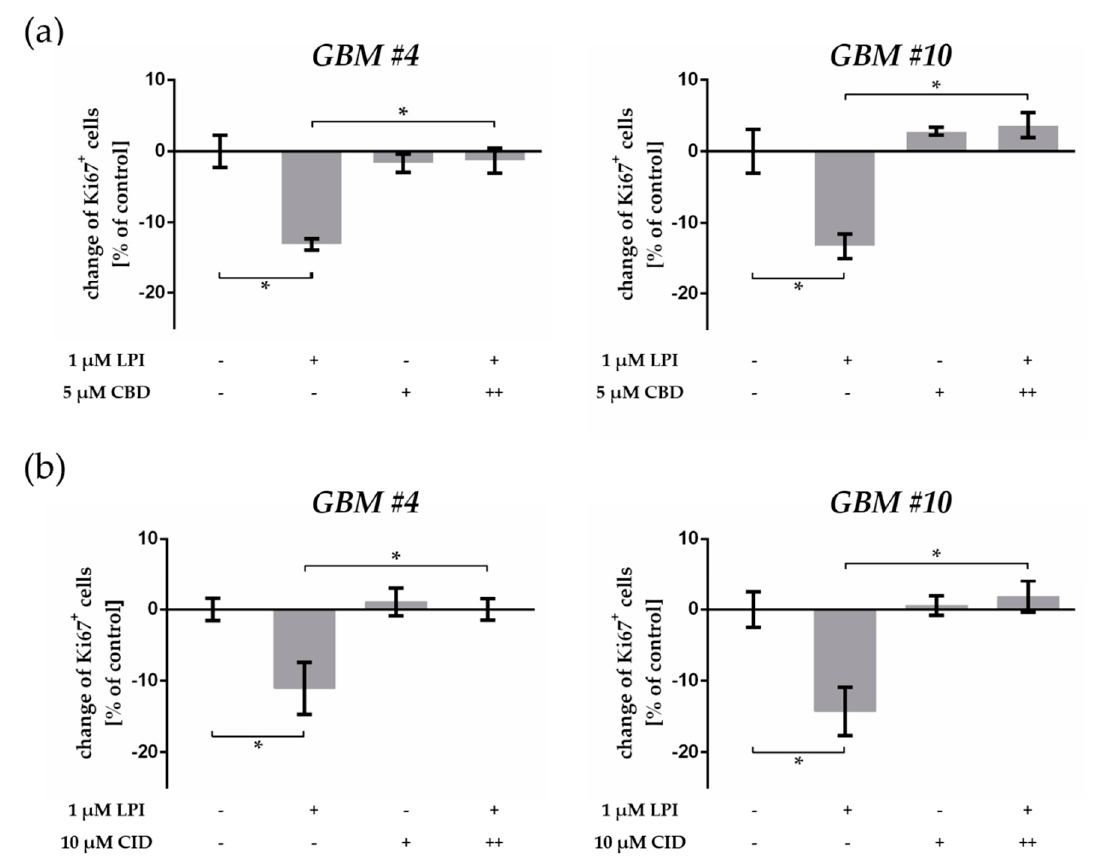
Figure 6. Effects of the endogenous GPR55 ligand lysophosphatidylinositol (LPI). ( a ) Impact of LPI on the number of Ki67-labelled GBM cells and impact of CBD on LPI effects. Application of LPI (1 µM) led to a decrease of Ki67 + cells in GBM #4 and GBM #10 compared to the control group. As obtained for THC, LPI effects were significantly prevented by a combination with CBD (5 µM), whereas CBD alone had no effects. ( b ) Impact of GPR55 antagonist CID16020046 (CID) on LPI effects. In the presence of GPR55 antagonist, CID (10 µM) responses to LPI were effectively inhibited. Cells treated with CID alone were unaffected compared to the control group. To block GPR55, CBD and CID were applied 15 min (++) before LPI was subsequently added. Data are means ± SEM of N = 3 independent experiments performed in duplicate. Significance was chosen for p < 0.05. The asterisk denotes significant results regarding the respective measurement indicated with the bar.